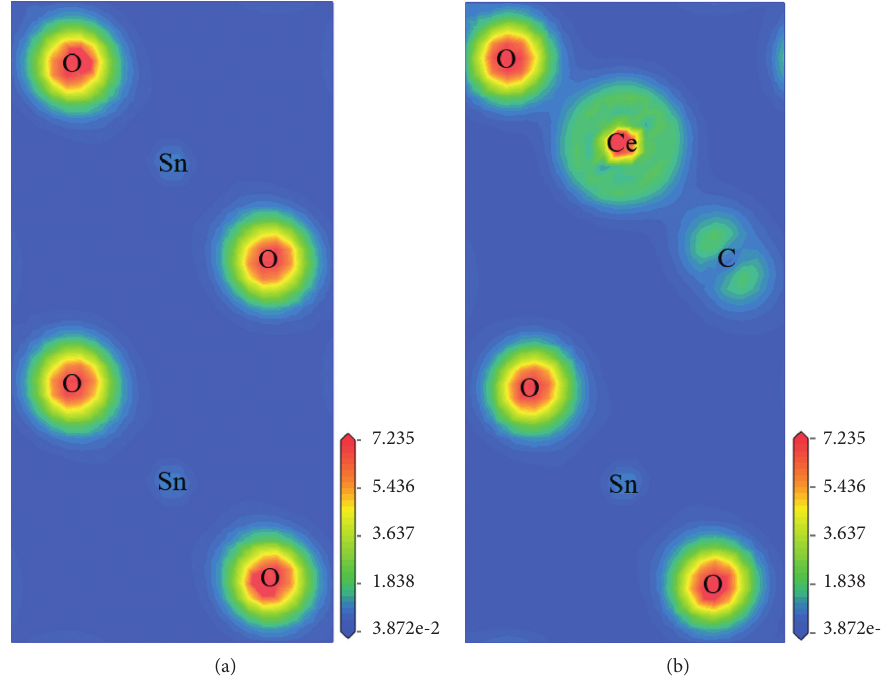
Figure 4: Plots of charge density contour: (a) SnO 2 and (b) Ce-C-SnO 2 . Table 2: Charge populations.